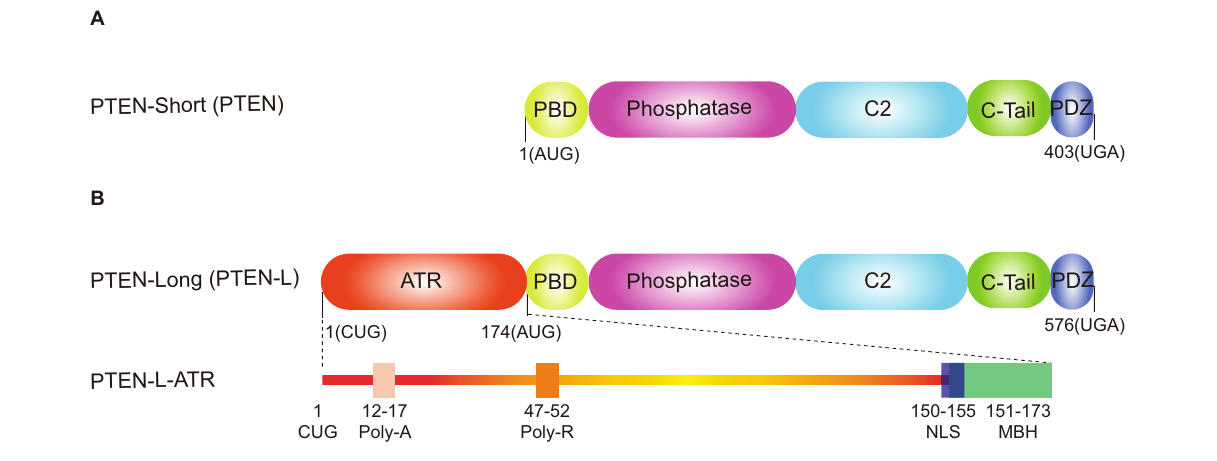
FIGURE 1 | Domain structure of phosphatase and tensin homolog (PTEN) isoforms. (A) PTEN-short (canonical PTEN), translated from an AUG start codon, contains five functional domains: a N-terminal PtdIns (4,5) P2 (PIP2)-binding domain (PBD), a dual phosphatase domain, a C2 domain, a C-tail domain, and PDZ-binding motif. (B) PTEN-long (PTEN-L) is translated from a CUG start codon upstream from the classic AUG start codon. In addition to the same five functional domains with the canonical PTEN, PTEN-L contains an alternatively translated region (ATR) adding 173 amino acids at the N-terminus. The extended ATR is composed of